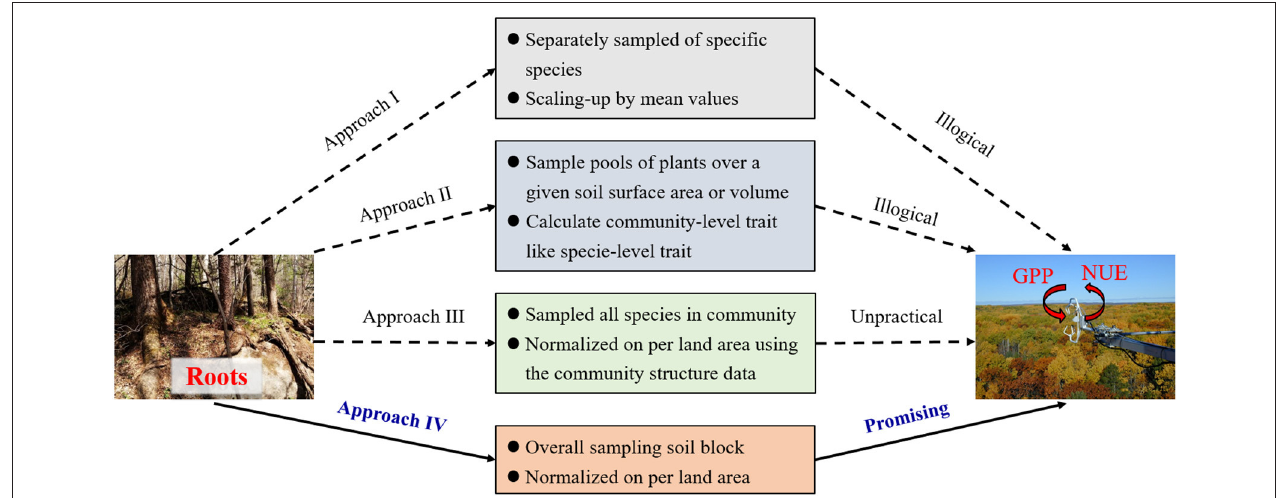
FIGURE 1 | Illustration of the four approaches used for linking root traits and ecosystem functioning in forests. GPP, gross primary productivity; NUE, nutrient-use efficiency. Approach I: root trait of dominant species or community-weighted means; Approach II: pooled-species trait; Approach III, ecosystem traits raised by He et al. (2019); Approach IV: root community traits (per unit land area). The advantages of Approach I and II are simple to conduct on the local scale and root trait data of each species is relatively easy to collect worldwide. However, mismatched units or dimensions lead to illogical linkages between root traits and ecosystem functioning in these two approaches. Although the Approach III could fill the gap of scale-matching between root traits and ecosystem functioning, it requires systematic measurements of all species within a community. Furthermore, some basic conversion parameters, such as root biomass and area per unit land area, are difficult to obtain. Through overall sampling soil block, Approach IV directly obtains the community-level root traits per unit land area, which not only has the potential to bridge the mechanistic linkages between root traits and ecosystem functioning, but also is feasible at the large